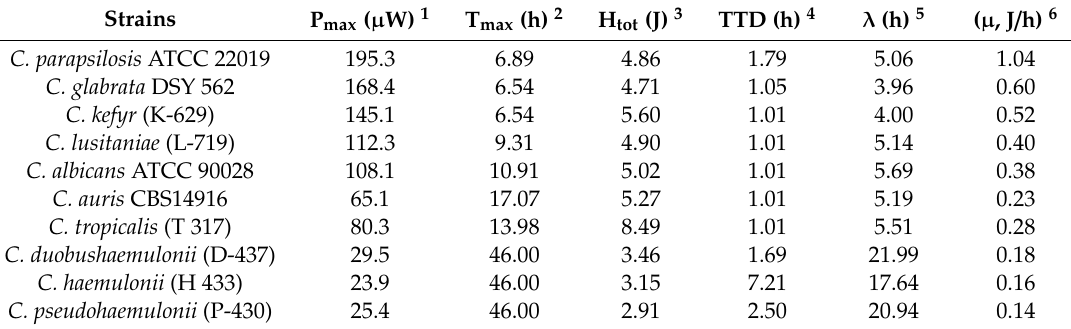
Figure 2. Microcalorimetry analysis of C. auris . Heat flow ( a ) and total heat ( b ) curves generated by planktonic C. auris 10051257, C. auris 10051259, C. auris 10051266, and C. auris 10051297 in RPMI 1640 at 37 °C.